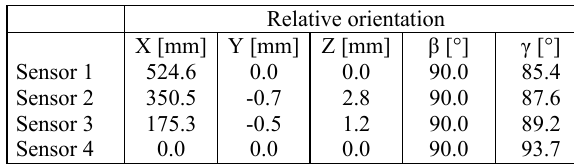
Table 1. Relative orientation of the fan-shaped distance meter